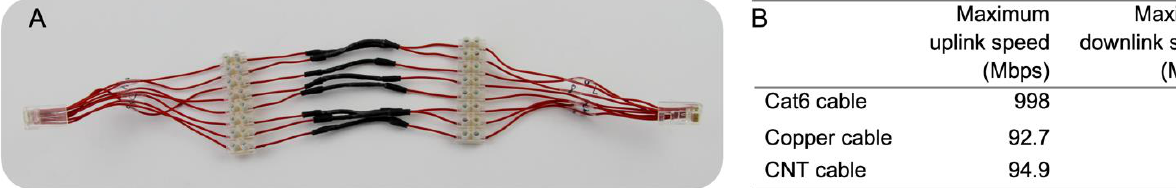
Figure 6. Photograph showing the CNT ethernet cable made using polystyrene-toluene feedstock ( A ), and the ethernet speed results using three devices, one (Cat6) commercial device and two lab made devices using CNTs or CU wire as active transmission component ( B ).